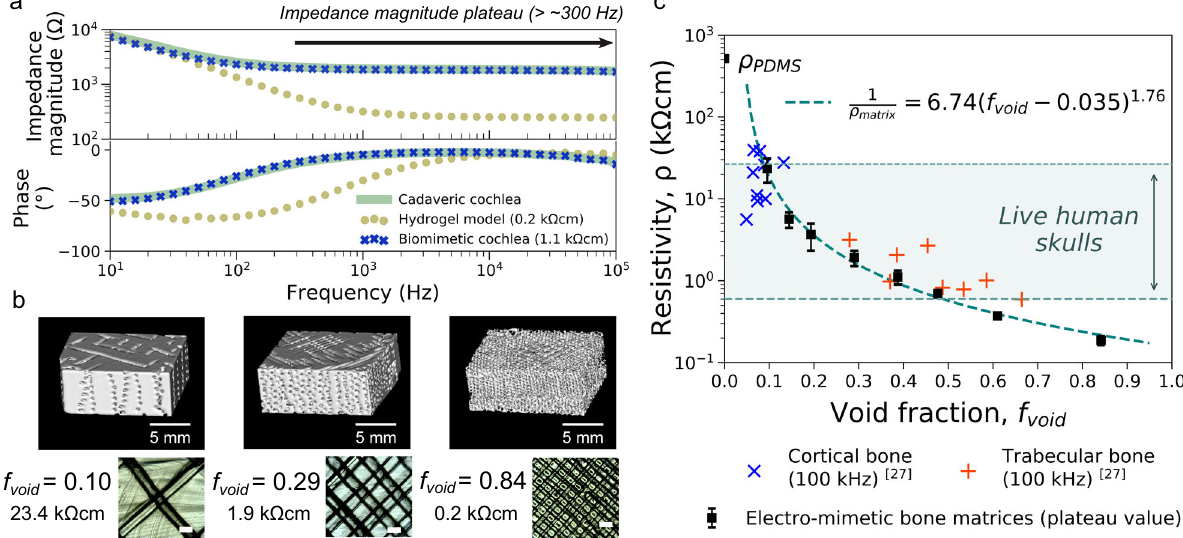
Fig. 2 Electrical properties of electro-mimetic bone matrices. a Bode plot showing the impedance properties of a cadaveric cochlea in a human head, and 3D printed cochlear models made of an electro-mimetic bone matrix and a hydrogel. The frequency range associated with the impedance magnitude plateau is indicated. b µ -CT reconstructed images (top) and optical microscopic images (bottom) of the electro-mimetic bone matrices at different volumetric void fractions ( f void ). Scale bar of the optical microscopic images = 500 µ m. The resistivities of the matrices were determined from their plateau impedance magnitude and the size of the samples. n = 3 independent samples. c Resistivity of the electro-mimetic bone matrices (plateau value, n = 3 independent samples) as a function of f void , compared to the reported resistivities of bovine cortical and trabecular bones 27 . The relationship between the resistivity of the electro-mimetic bone matrix and f void is well-described by a percolation equation of a conductor-insulator composite 54 (Supplementary Fig. 3e). Data were presented as mean values±